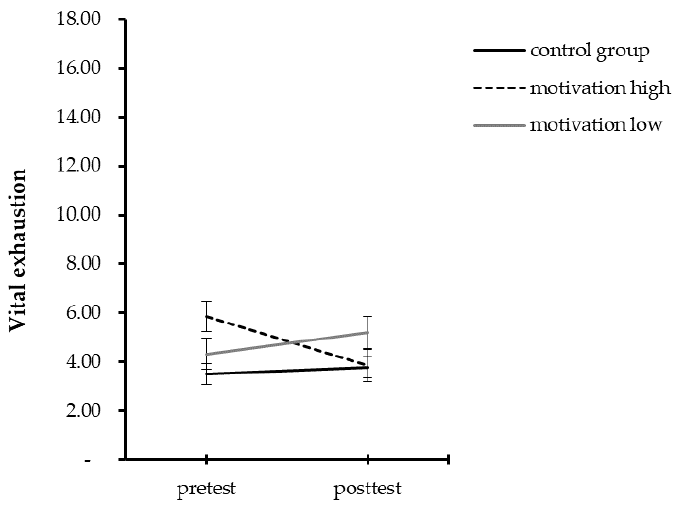
Figure 2. Mean summary for pre- and post-test scores for vital exhaustion separated by groups.